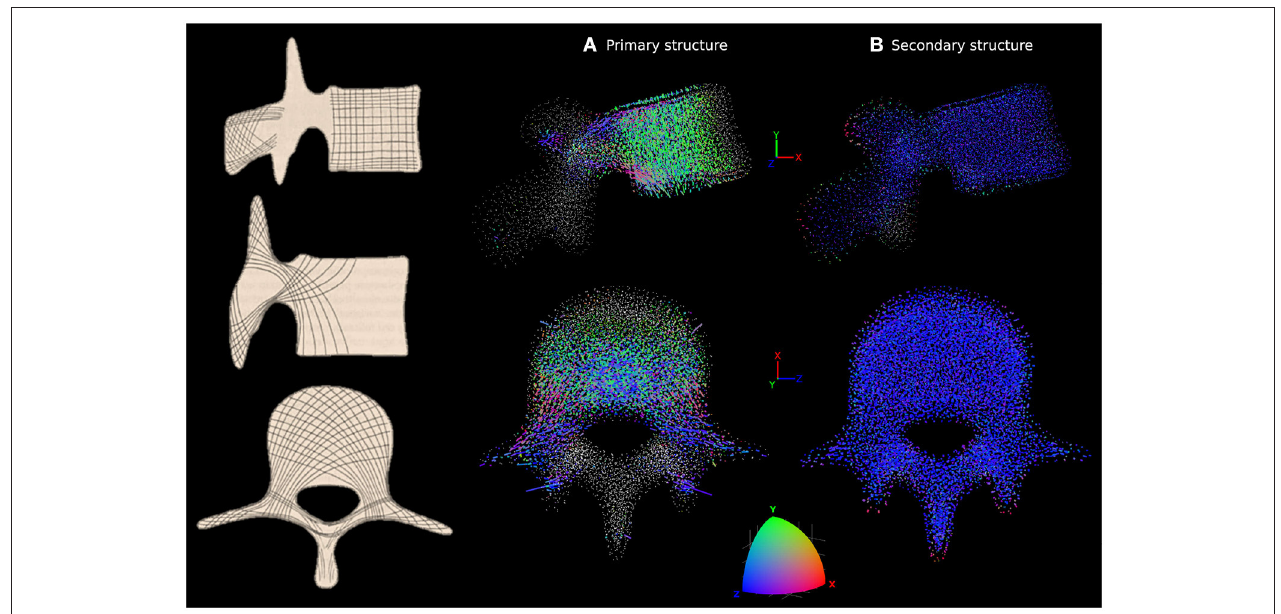
FIGURE 5 | Characterisation of anisotropy in the trabecular bone of L4 adapted to the healthy scenario. In-vivo observations by Gallois and Japiot (1925) are shown on the left. (A) Shows the orientation of the trabecular trusses of the primary structure (with a radius larger than 0.1 mm ). (B) Shows the orientation of the trabecular trusses of the secondary structure (with a radius of 0.1 mm ). For (A,B) , side view (top row) and top view (bottom row) are shown. Lines are attached to each trabecular node, with colour and length varying respectively with the orientations and radii of the truss elements connected to that particular node. The colour scale at the bottom shows how the colour of the lines should be interpreted. Orientation along the X, Y, or Z axes are in red, green, or blue, respectively. Any orientation that is not colinear with these axes shows as a combination of red, green and blue. A white dot indicates a node without elements in the size range being looked at connected to